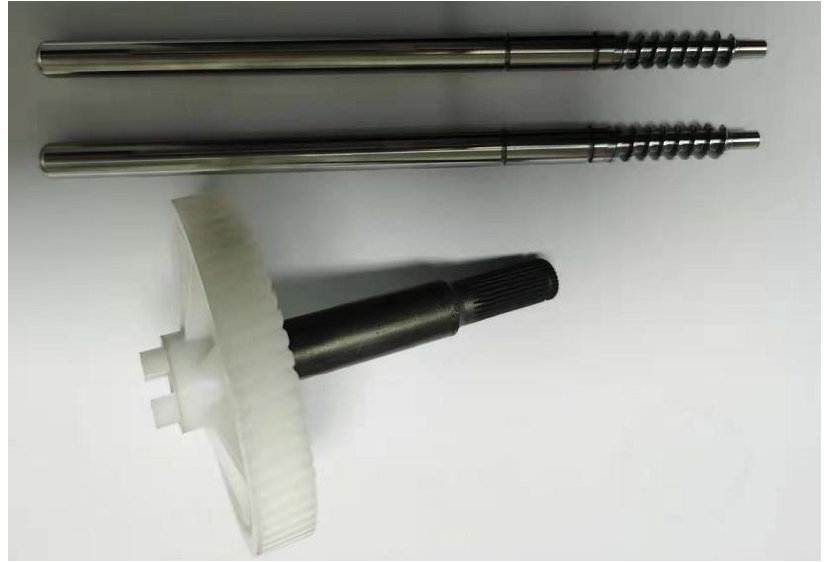
Figure 6. Worm and plastic gear samples.